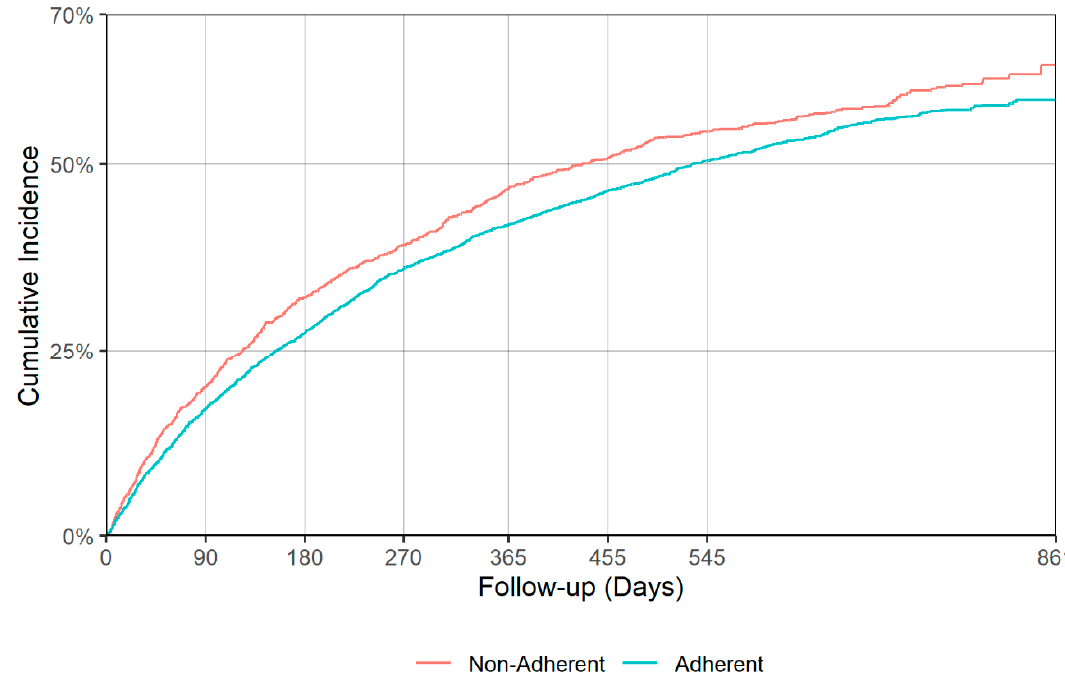
Figure 5. IPT-weighted cumulative incidence function of all-cause hospitalization, adjusting for death before hospitalization as a competing risk (acute phase). Modified Gray’s test p = 0.018.